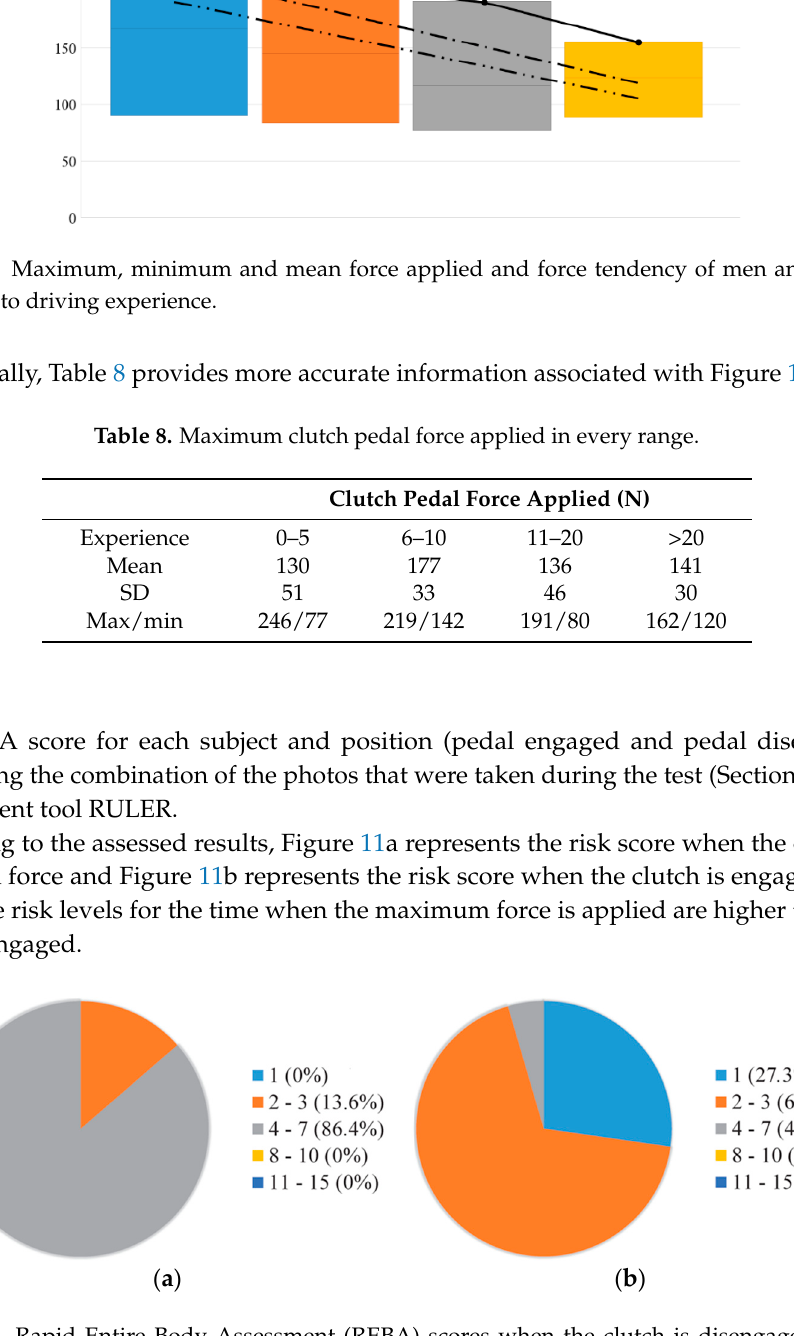
Figure 11. Rapid Entire Body Assessment (REBA) scores when the clutch is disengaged ( a ) and engaged ( b